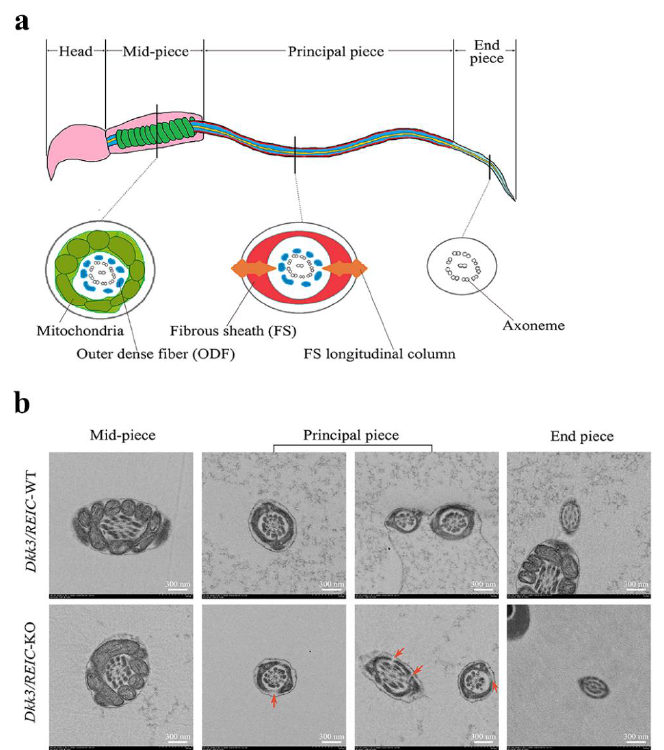
Figure 4. Transmission electron microscope observation of Dkk3/REIC -WT and Dkk3/REIC -KO sperm. ( a ) Schematic drawing of the mouse sperm ultrastructure. The sperm flagellum can be divided into three parts, which are the mid-piece, principal piece, and end piece. Their cross section views are different from each other, and the fibrous sheath structure mainly exists in the principal piece. ( b ) The TEM images of Dkk3/REIC -WT and Dkk3/REIC -KO sperm. No obvious difference was found between the mid-piece and end piece; hwoever, the principal piece of Dkk3/REIC -KO sperm showed irregular fractures in the fibrous sheath